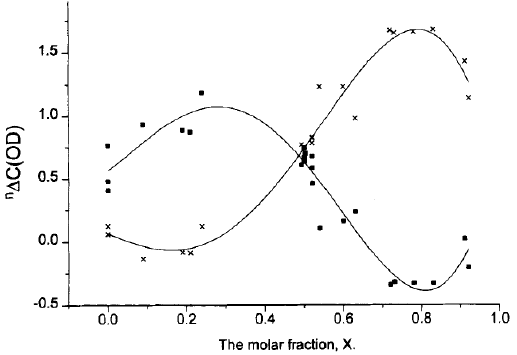
Figure 17. Top: Primary tritium, deuterium isotope effects. Bottom: Deuterium isotope effects on 13 C chemical shifts. Taken from Ref. [98] with permission from John Wiley and sons.